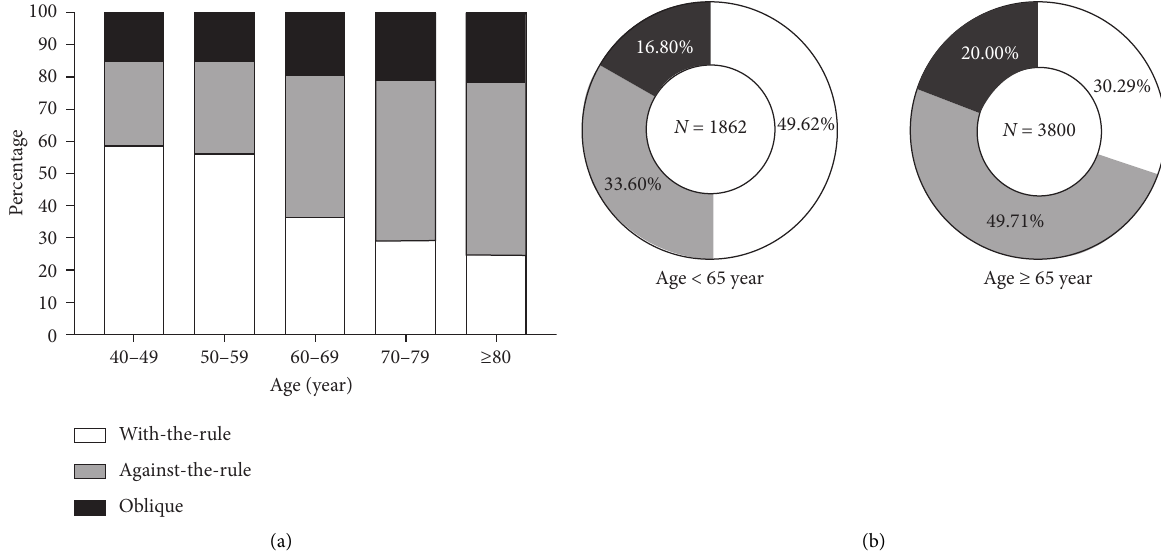
Figure 4: Relationship between corneal astigmatism axis and age. (a) Changes in corneal astigmatism axis with age. (b) Differences in the corneal astigmatism axis in age Table 2: Spearman’s correlation analysis of corneal astigmatism and age in three types of astigmatism axis. Corneal astigmatism